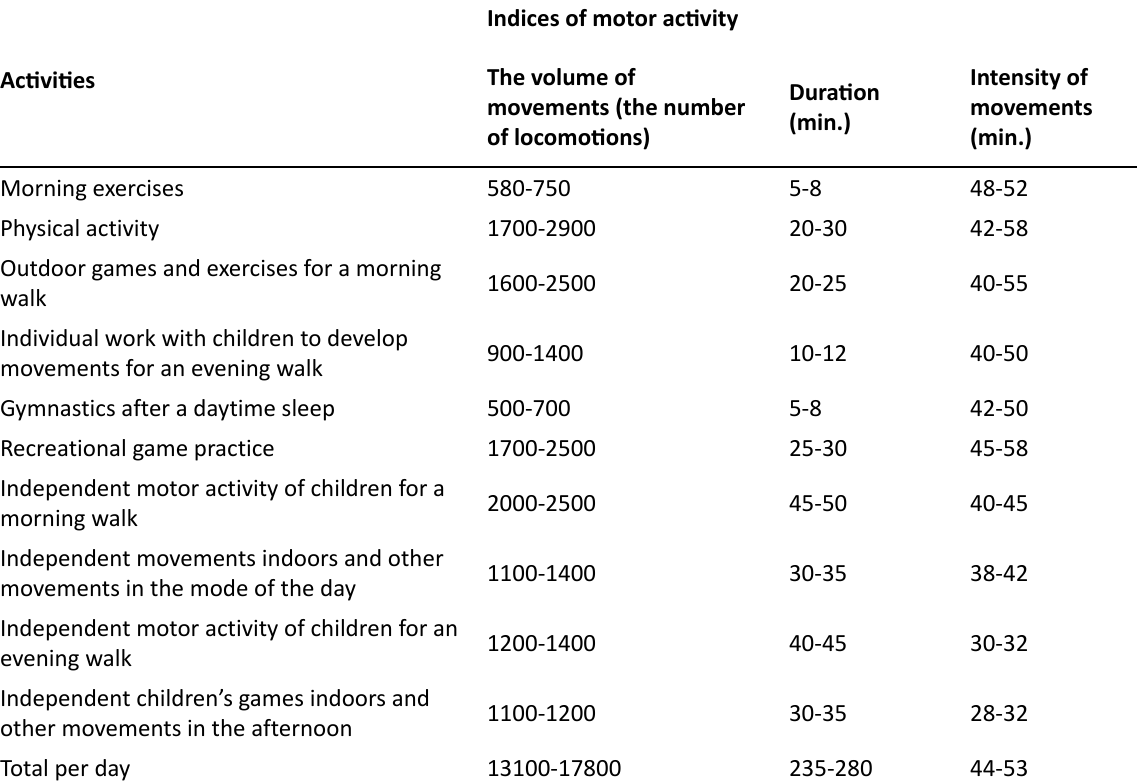
Table 2. Indicative figures of motor activity for children aged 3-4